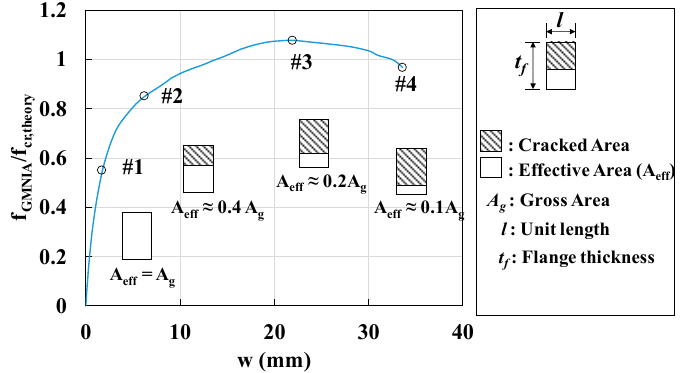
Figure 23. Variation of effective area during each loading sequences.